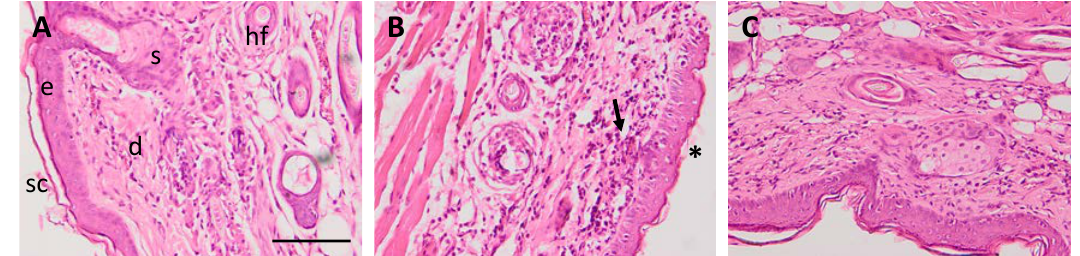
Figure 6. Representations of histological sections (original magnification, × 200) of mouse skin: ( A ) control conditions/negative control; ( B ) oxazolone-induced atopic dermatitis/positive control; and ( C ) PGZ-NE treatment in mice with oxazolone-induced atopic dermatitis. Skin structures: epidermis (e) dermis (d), sebaceous gland (s), hair follicle (hf), stratum corneum (sc), loss of stratum corneum (asterisk), and inflammatory cell infiltrate (black arrow). Scale bar = 100 µm.